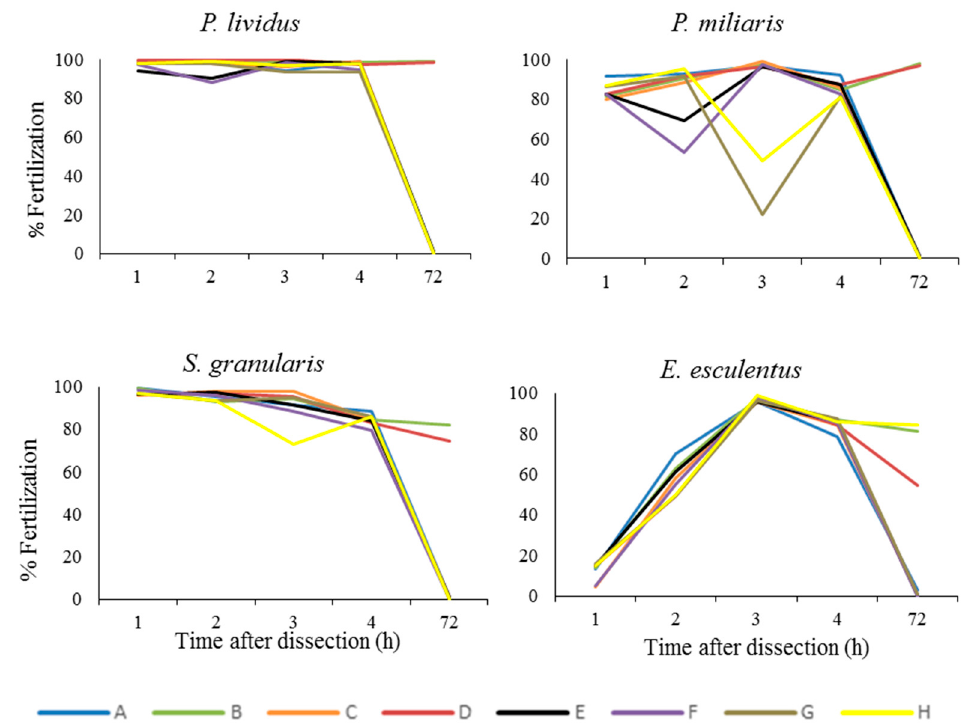
Figure 3. Percentage of fertilization after storage of the gametes at room temperature (18 ◦ C) and fridge temperature (4 ◦ C) for four species of sea urchins. The treatment combinations used to observe fertilization after 1, 2, 3, 4 and 72 h of keeping the gametes at 4 ◦ C and 18 ◦ C were the following: (A) 4 ◦ C sperm in the gonad with 18 ◦ C oocyte; (B) 4 ◦ C sperm in gonad with 4 ◦ C oocyte; (C) 4 ◦ C activated sperm with 18 ◦ C oocyte; (D) 4 ◦ C activated sperm with 4 ◦ C oocyte; (E) 18 ◦ C sperm in the gonad with 18 ◦ C oocyte; (F) 18 ◦ C sperm in the gonad with 4 ◦ C oocyte; (G) 18 ◦ C activated sperm with 18 ◦ C oocyte; (H) 18 ◦ C activated sperm with 4 ◦ C oocyte.